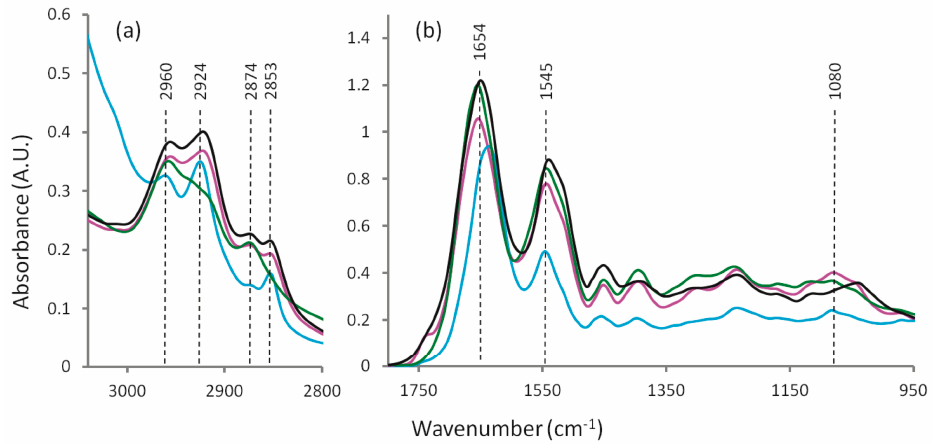
Figure 2. Average Fourier-transform infrared (FTIR) spectra from the liver tissue: hydrated tissue attenuated total reflectance (ATR) spectrum (blue), formalin fixed transmission spectrum (black), desiccator dried transmission spectrum (pink) and ethanol dehydrated transmission spectrum (green): ( a ) 3040–2800 cm − 1 region and ( b ) 1800–950 cm − 1 region. Reproduced from reference [17].